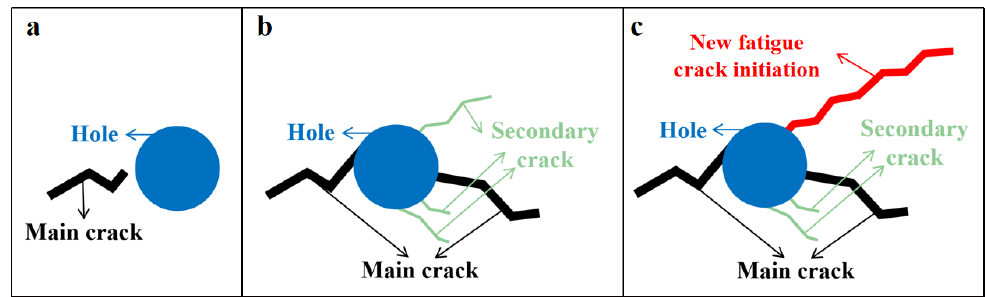
Figure 16. Expansion of cracks when holes are encountered: ( a ) hole and main crack; ( b ) secondary crack; ( c ) new fatigue crack initiation .